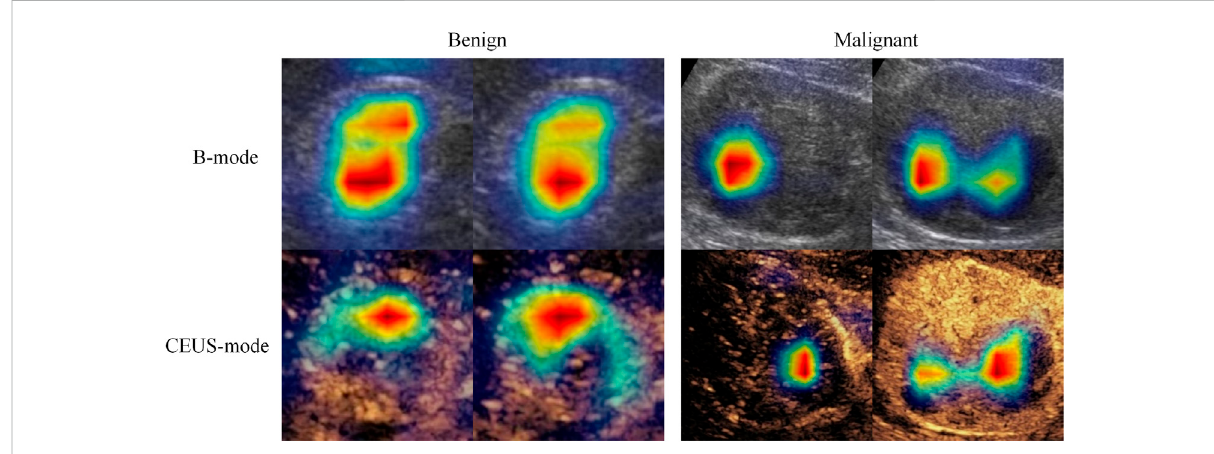
FIGURE 5 FeatureheatmapsofabenigntumorandamalignanttumortoshowB-modeandCEUS-modeimagescontaincomplementaryinformationfor diagnosis. The red color represents higher weights (i.e., the network pays more attention to this